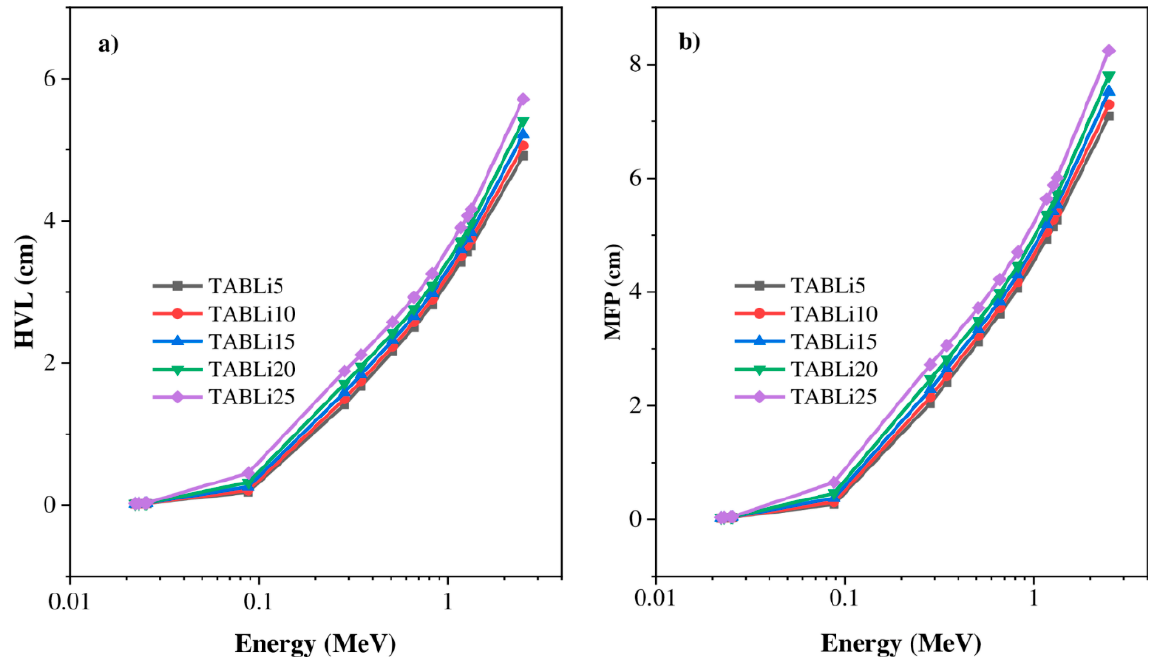
Figure 9. The dependence of the ( a ) half-value layer and ( b ) mean free path on the incoming gamma photons.